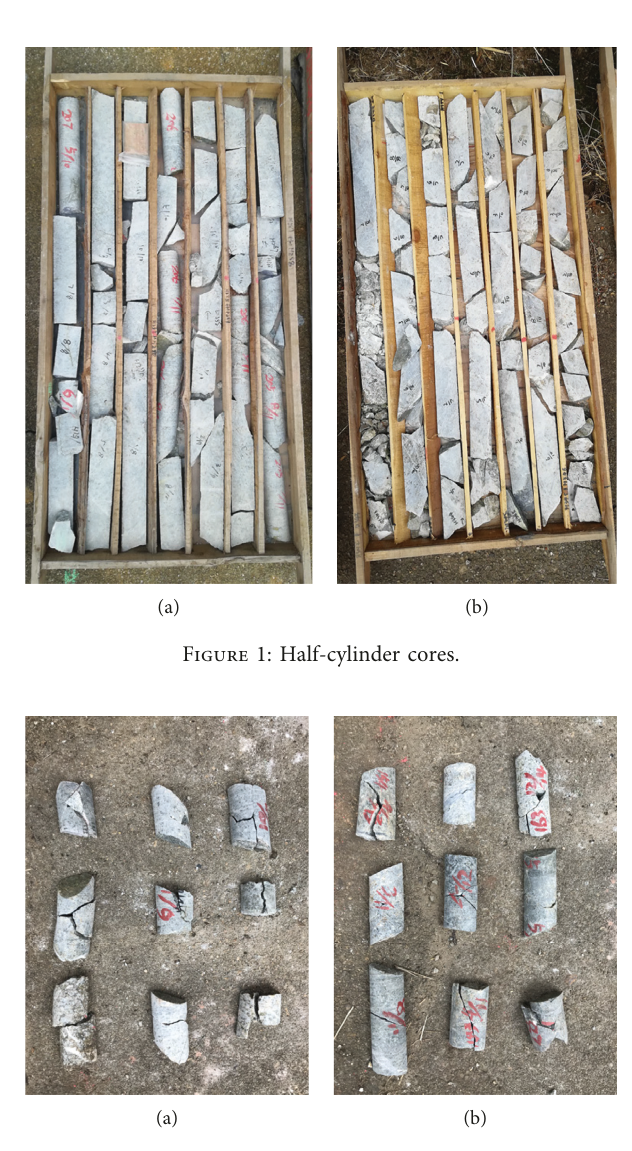
Figure 2: The half-cylinder cores after breaking under PLT.